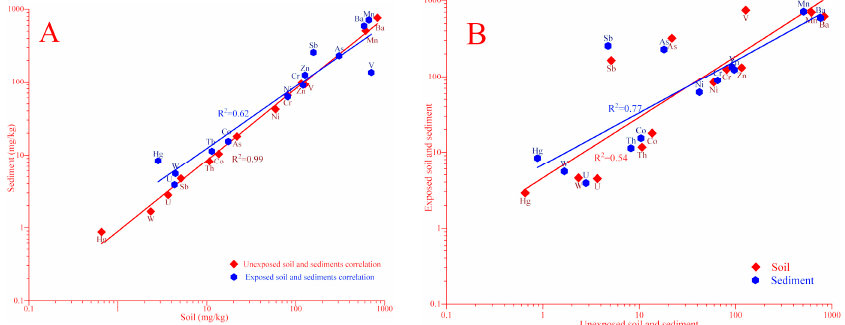
Figure 4. Correlation of average values of elements in unexposed soil and sediment (red line) and anthropogenically exposed soil and sediment samples (blue line) ( A ); as well as correlation between unexposed and anthropogenically exposed soil (red line) and unexposed and anthropogenically exposed sediment samples (blue line) ( B ).